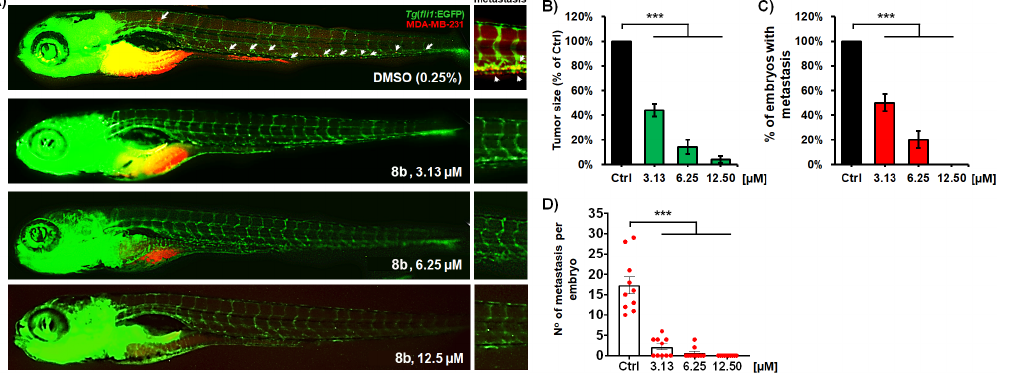
Figure 10. Anti-cancer and anti-metastatic activity of a new HDAC inhibitor 8b against highly metastatic human breast carcinoma MDA-MB-231 cells in zebrafish xenografts. Tg(fli1:EGFP) xenografts ( n = 20) were exposed to three different doses of 8b , and analyzed for tumor progression and metastasis after 3-day treatment. Representative fluorescent microscopy images are shown ( A ); white arrows indicate disseminated cells. The applied treatments markedly reduced the MDA-MB-231 tumor growth ( B ), number of embryos with metastasis ( C ), as well as the number of disseminated cancer cells per xenograft ( D ), as compared to those in the control group ( p < 0.001, for all hallmarks). Data are normalized in relation to the control group (( B – D ) *** p < 0.001).